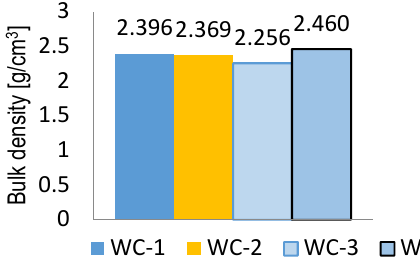
Figure 4. Bulk density of mineral-asphalt mixtures.